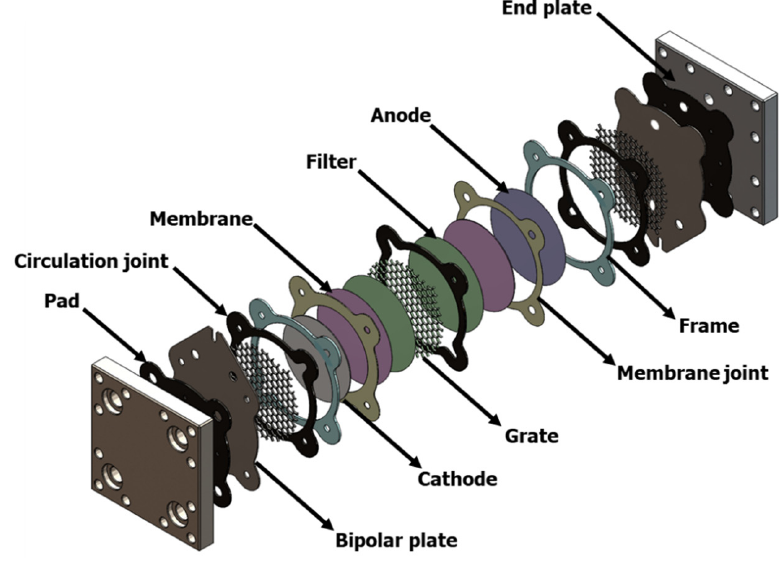
Figure 1. 3D view of the electrolysis cell.